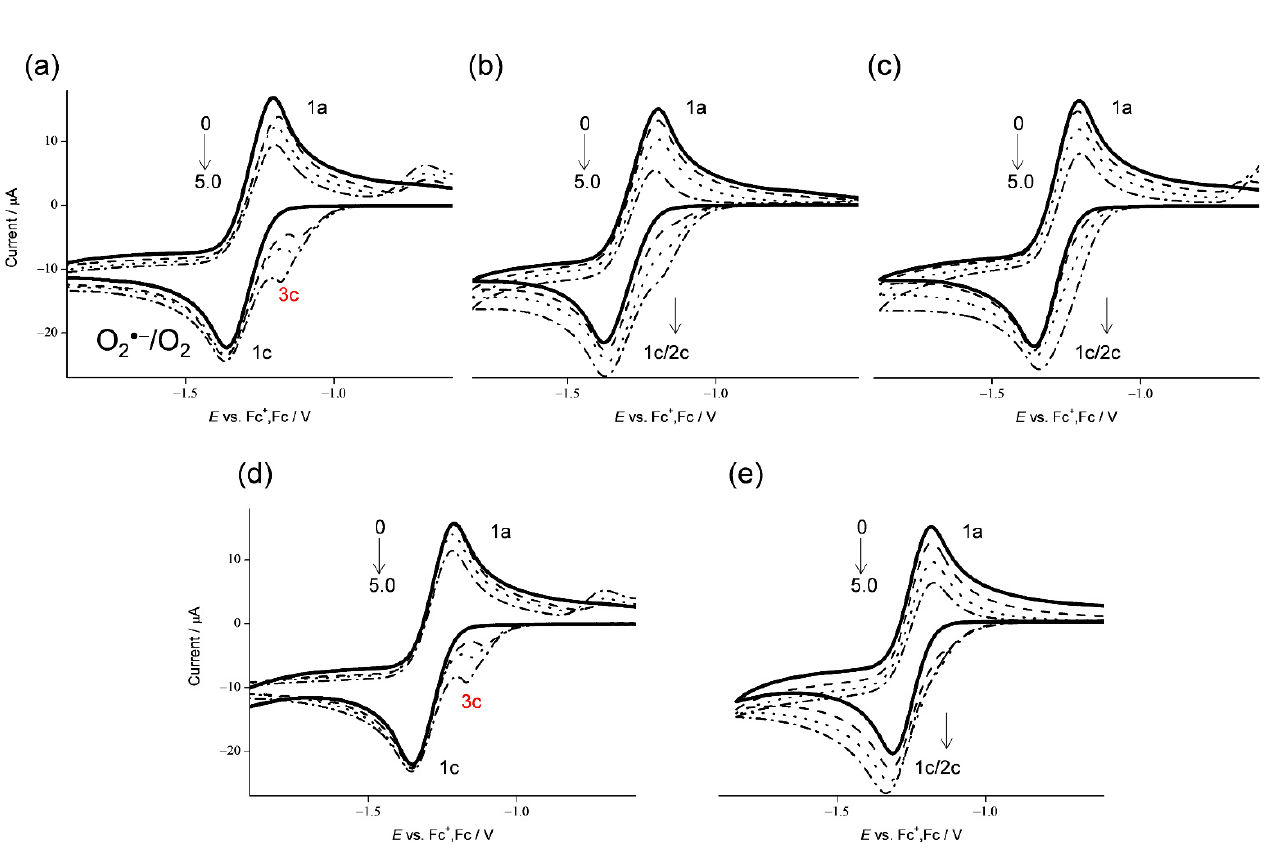
Figure 1. CVs of 4.8 × 10 − 3 mol dm − 3 O 2 in the presence of ( a ) CafH 2 (COOH), ( b ) ferulic acid, ( c ) isoferulic acid, ( d ) Et-CafH 2 , and ( e ) p -coumaric acid, in DMF containing 0.1 mol dm − 3 TPAP. All CVs were recorded with a GC electrode at a scan rate of 0.1 V s − 1 . Concentrations (×10 − 3 mol dm − 3 ) are 0, 1.0, 3.0, and 5.0 (arrows indicate the concentration changes).